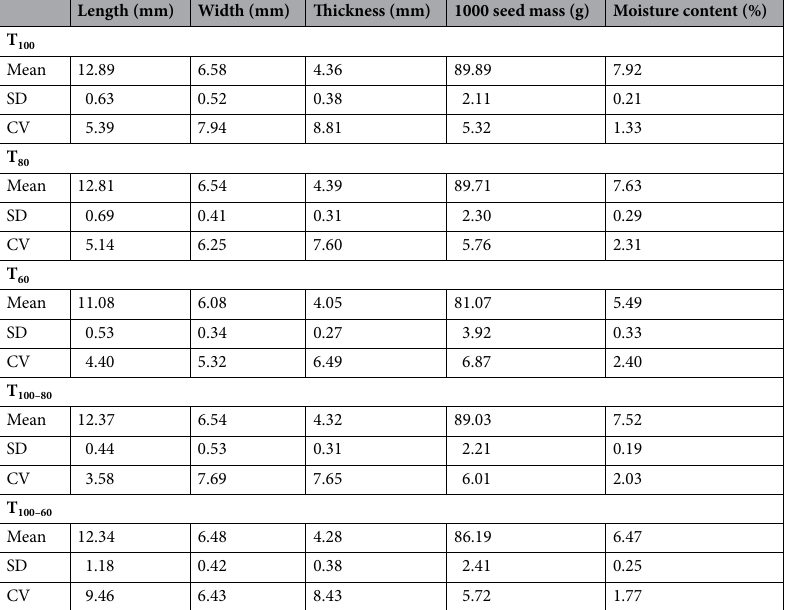
Table 1. The dimensions, mass and moisture content for seeds. SD standard deviation, CV coefficient of variation %.